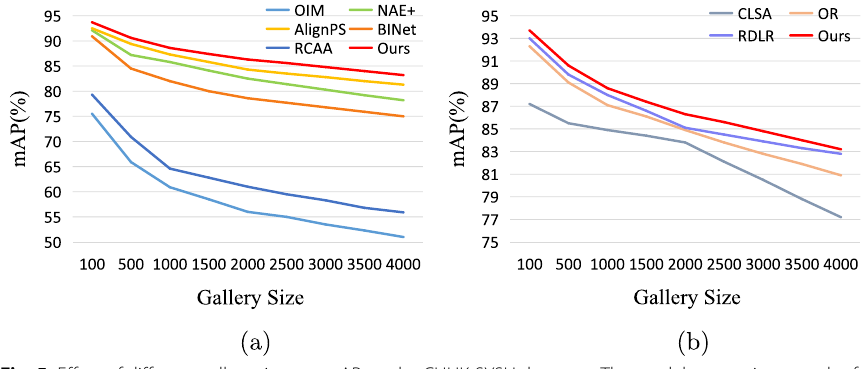
Fig. 5 Effect of different gallery sizes on mAP on the CUHK‑SYSU dataset. a The model comparison graph of the one‑step. b The model comparison graph of the